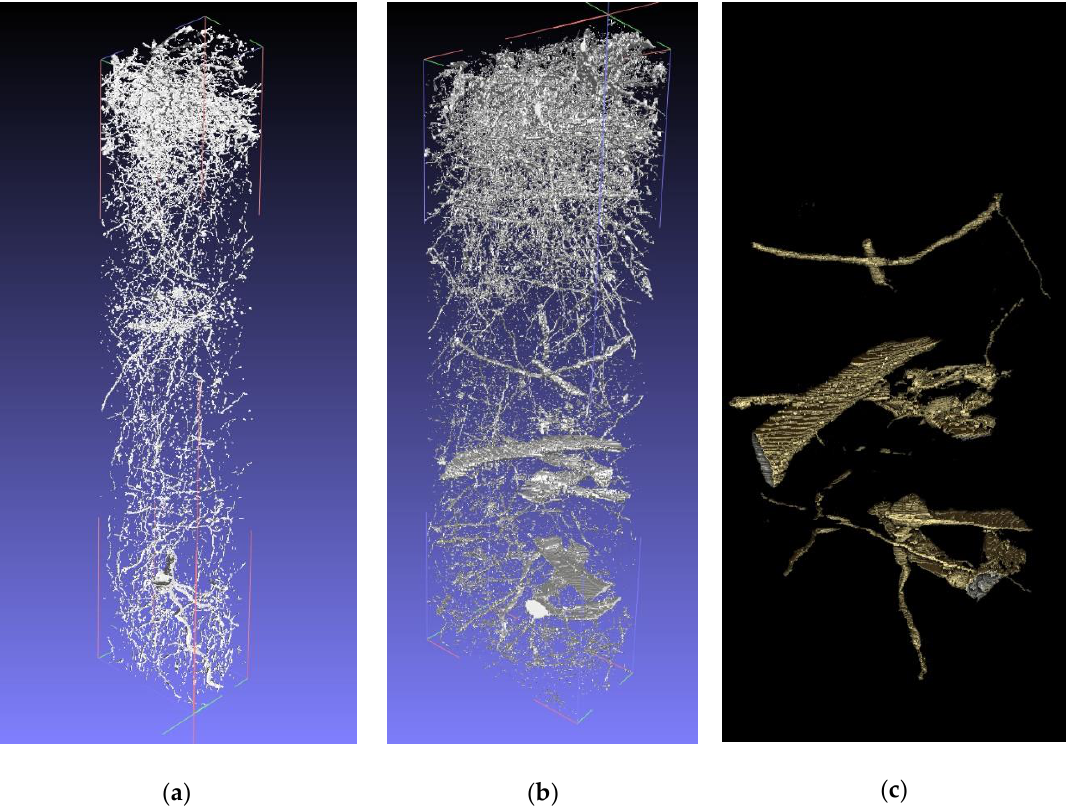
Figure 7. ( a ) Mesh of 3D model RWSN (size filtered with ice removed), ( b ) mesh of 3D model RWSS (size filtered with ice removed), ( c ) 3D model of reed rhizomes extracted from model RWSS (size filtered with ice removed).